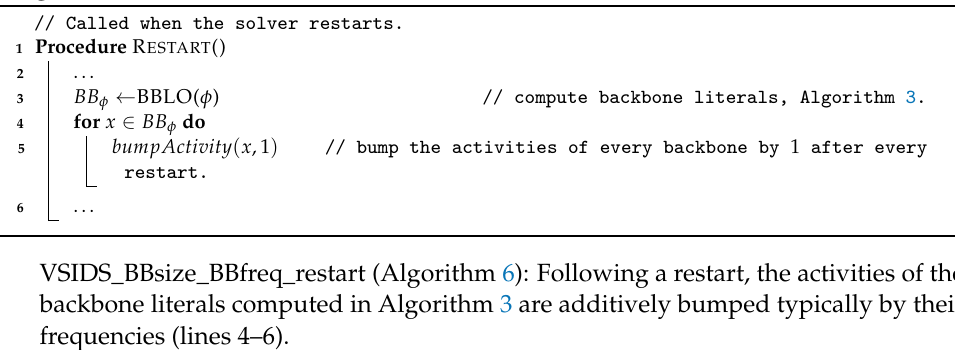
Algorithm 5: VSIDS_BBsize_restart a variant of the VSIDS decision heuristic.